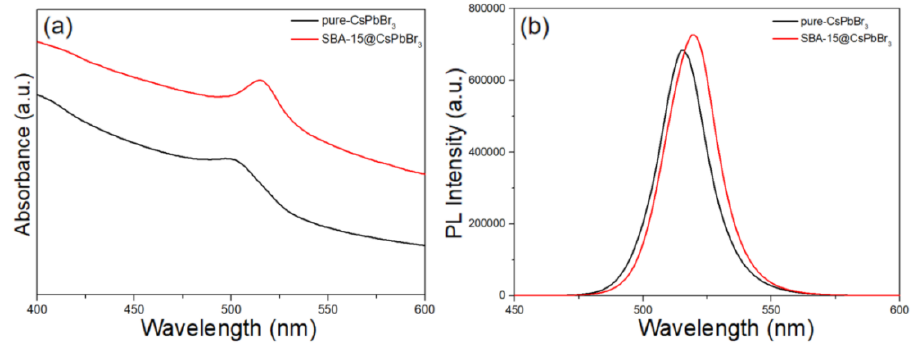
Figure 1. ( a ) UV-Vis absorption of pure CsPbBr 3 QDs (black) and SBA-15@CsPbBr 3 QDs (red); ( b